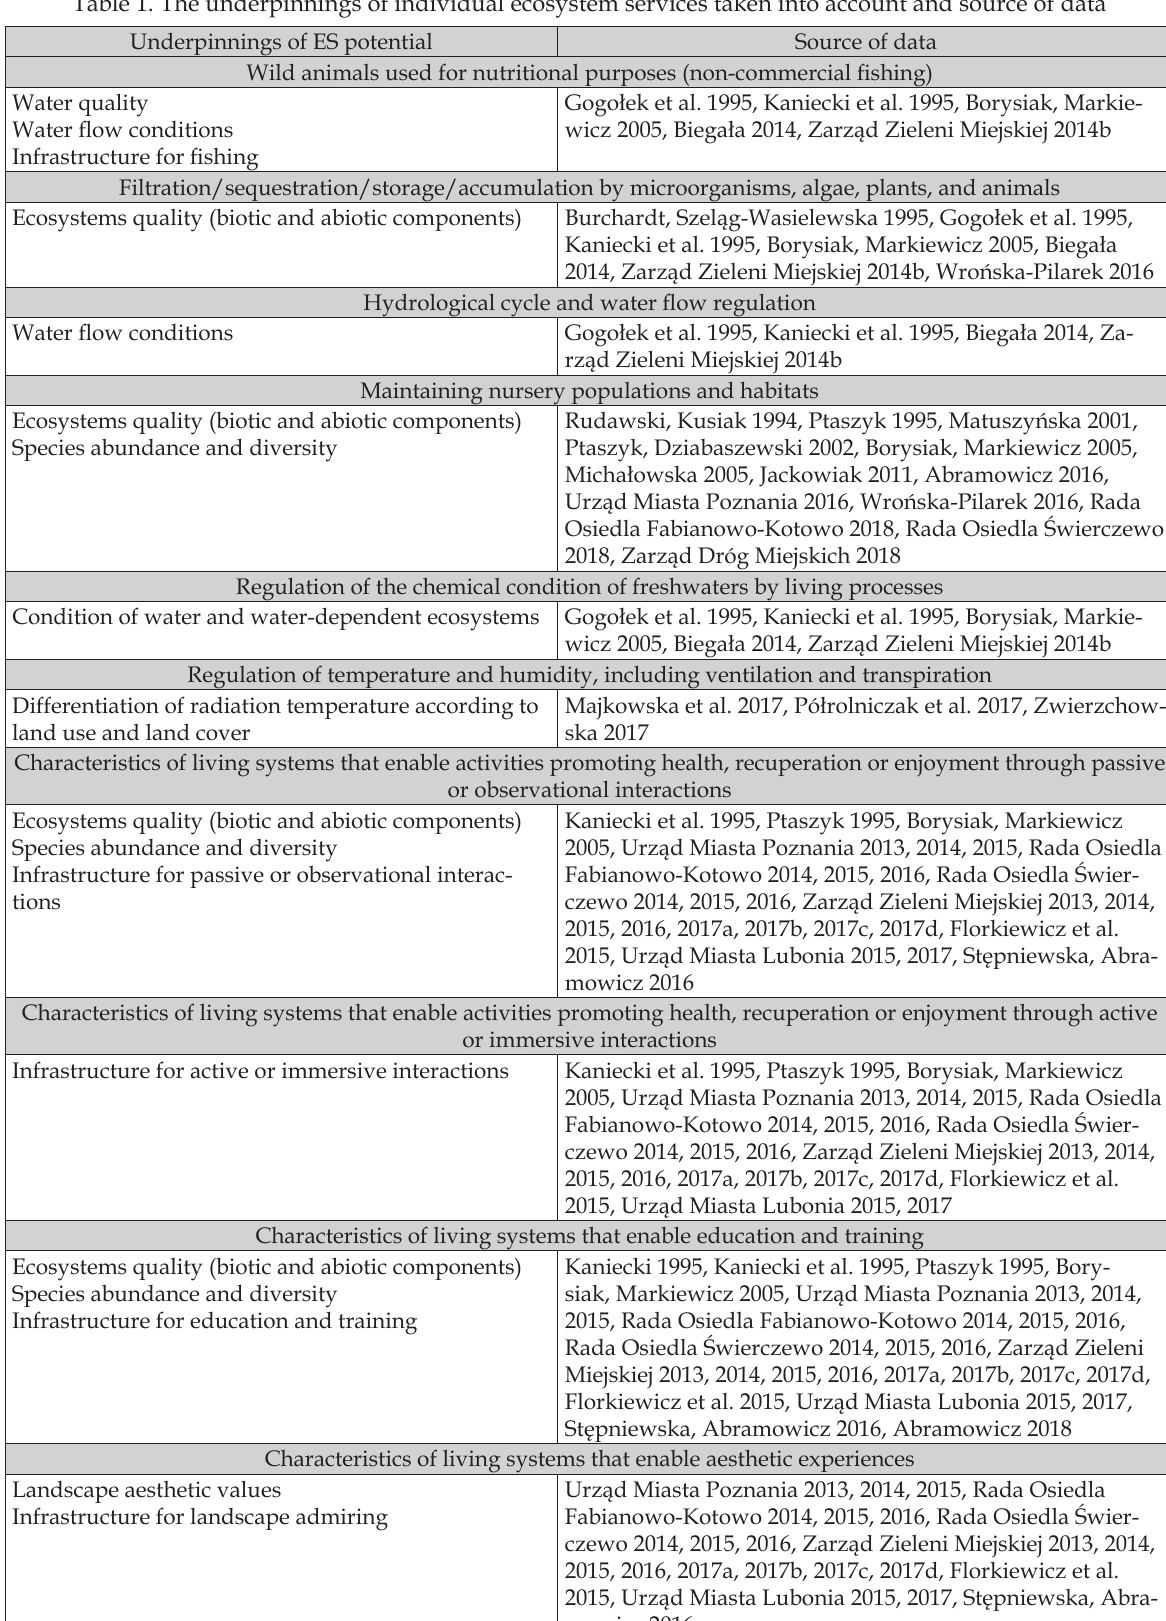
Table 1. The underpinnings of individual ecosystem services taken into account and source of data Underpinnings of ES potential Source of